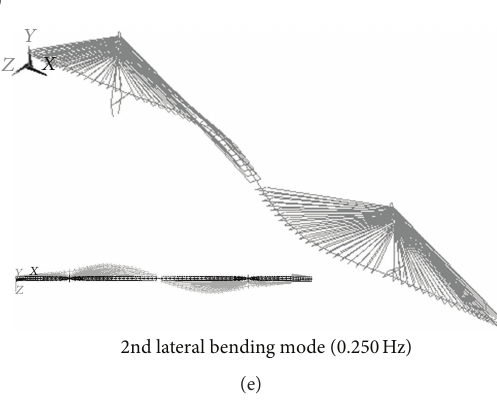
Figure 9: First mode shapes from the updated FE